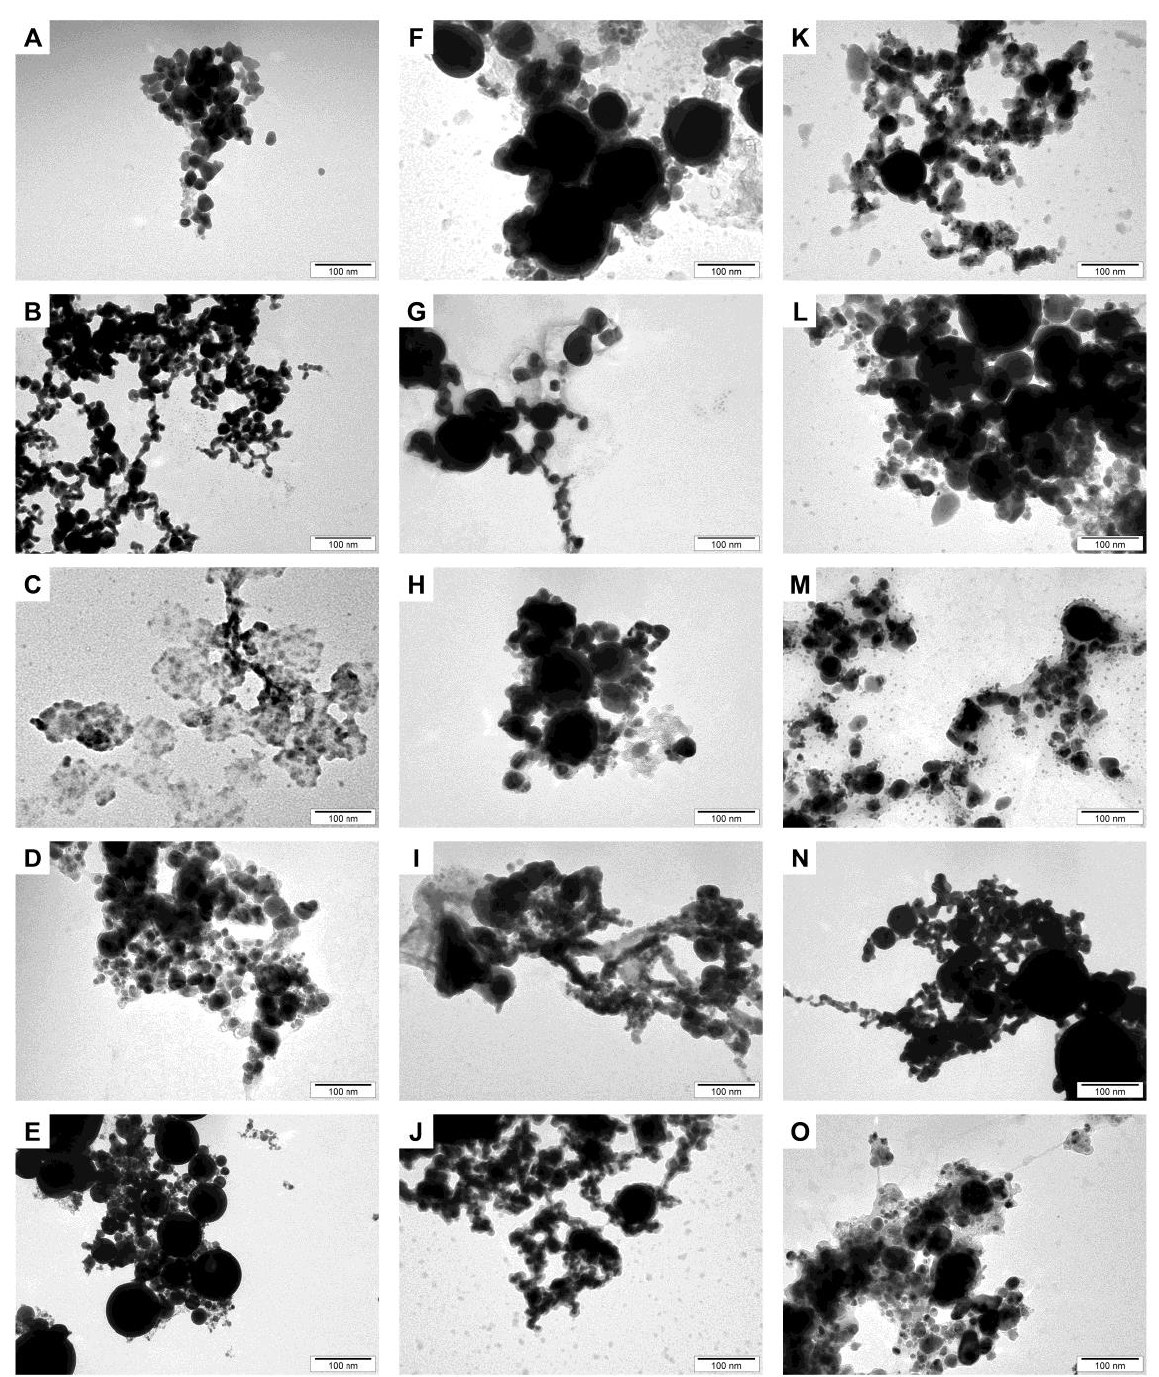
Figure 1. Transmission electron microscopy (TEM) images of the studied nanoparticles and their complexes. ( A )—AgNPs, ( B )—AuNPs, ( C )—CuNPs, ( D )—FeNPs, ( E )—PtNPs, ( F )—AgFeNPs, complexes. ( A ) — AgNPs, ( B ) — AuNPs, ( C ) — CuNPs, ( D ) — FeNPs, ( E ) — PtNPs, ( F ) — AgFeNPs, ( G )—AuAgNPs, ( H )—AuFeNPs, ( I )—CuAgNPs, ( J )—CuAuNPs, ( K )—CuPtNPs, ( L )—CuFeNPs, ( G ) — AuAgNPs, ( H ) — AuFeNPs, ( I ) — CuAgNPs, ( J ) — CuAuNPs, ( K ) — CuPtNPs, ( L ) — CuFeNPs, ( M )—PtAgNPs, ( N )—PtAuNPs, ( O ( M ) — PtAgNPs, ( N ) — PtAuNPs, ( O ) — PtFeNPs.